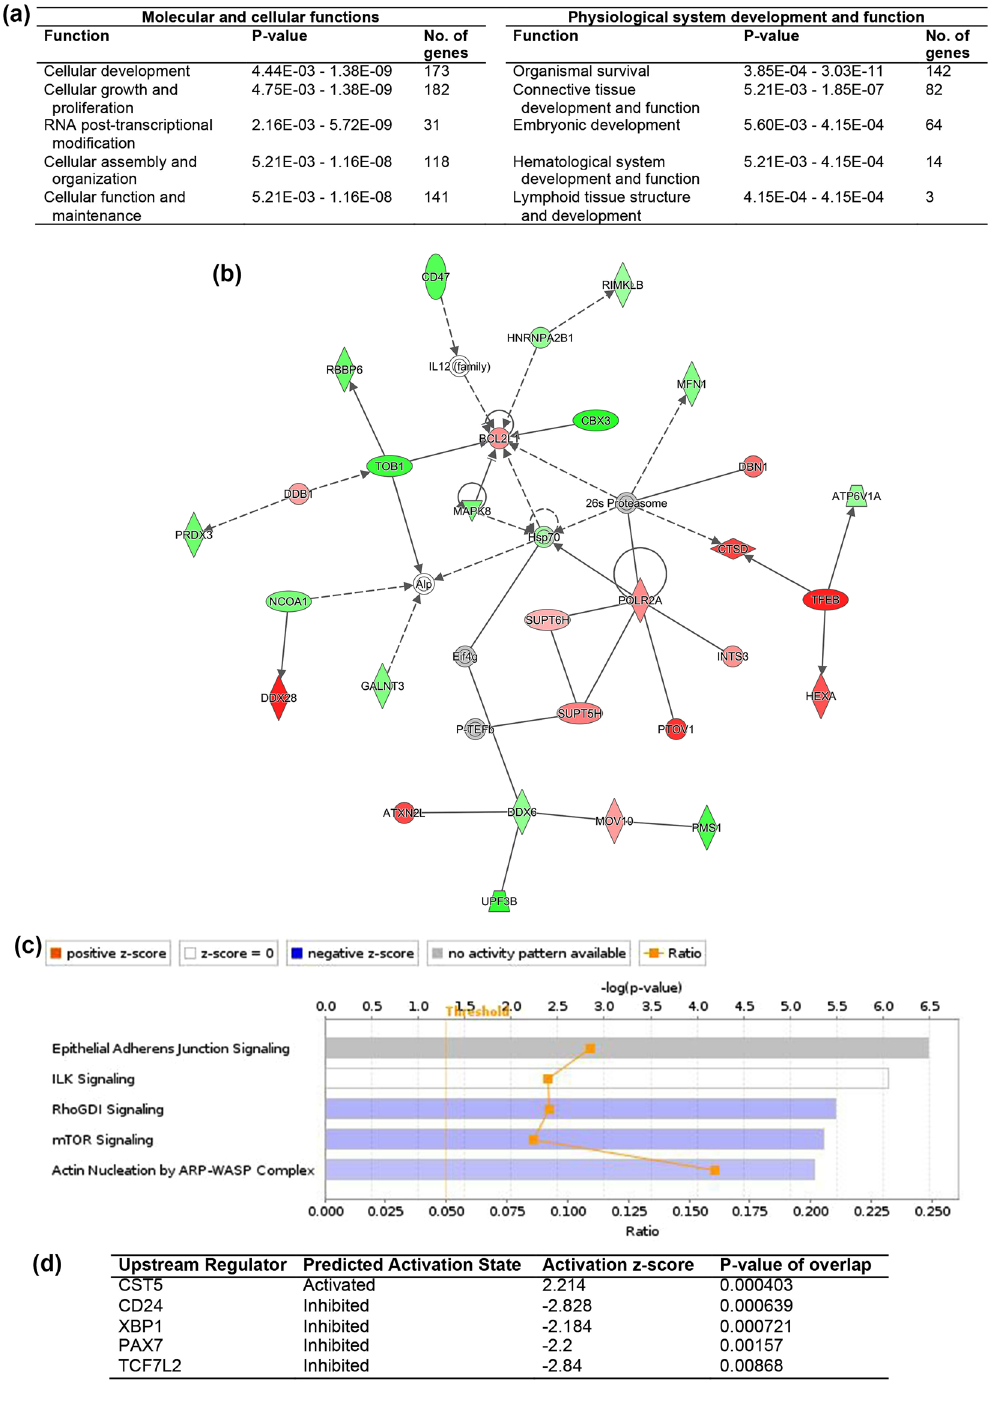
Figure 2. IPA analysis of DEGs from the comparison between miNT and SCNT blastocysts derived from depleted cells (n = 3 to 4/group). ( a ) List of the top five biological functions. ( b ) Gene interaction network involved in gene expression, cell morphology, and cellular function and maintenance. Upregulated and downregulated genes are represented in red and green, respectively. The intensity of colour represents the degree of regulation. Colourless or grey nodes are genes involved in the network which were obtained from the Ingenuity Knowledge Base. The solid and dashed lines represent direct and indirect interactions, respectively. ( c ) The top five statistically significant canonical pathways. ( d ) List of upstream